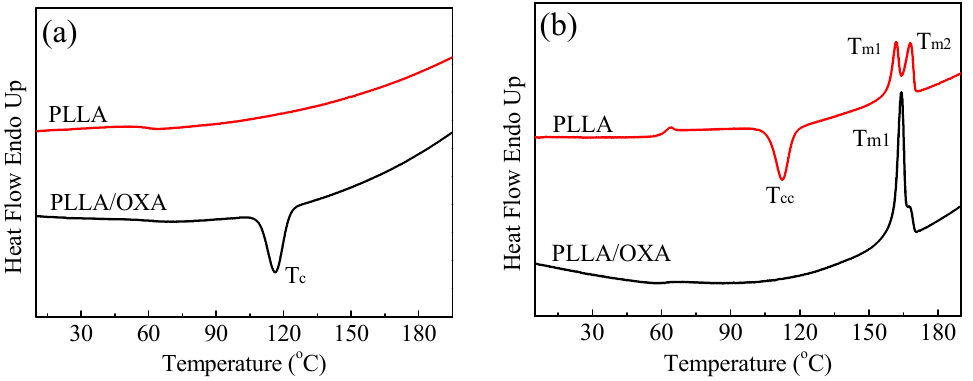
Figure 2 . Differential scanning calorimetry (DSC) curves of the PLLA and PLLA/OXA samples: ( a ) cooling from the melt and ( b ) subsequent heating processes. The cooling and heating rates are 10 °C/min.